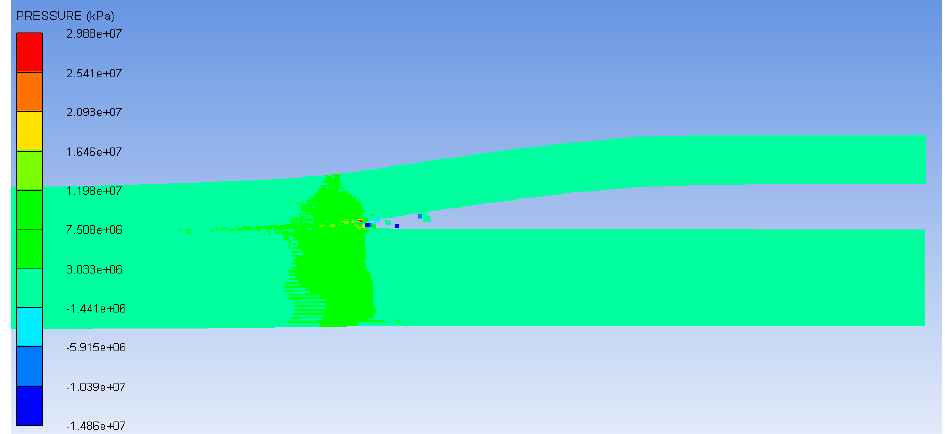
Figure 6. The contour of the pressure distribution.